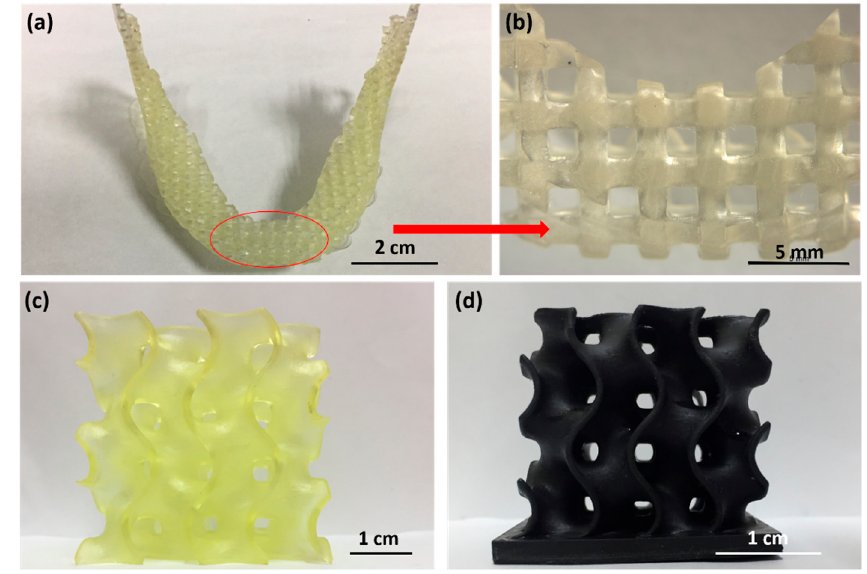
Figure 8. Images of ( a ) pure UV-cured resin with a square architecture and ( b ) a close view of the circled area in ( a ), showing smooth surface finish with relatively high resolution. Images of ( c ) pure UV-cured resin and ( d ) graphene-reinforced nanocomposite gyroid scaffold for bone tissue engineering.